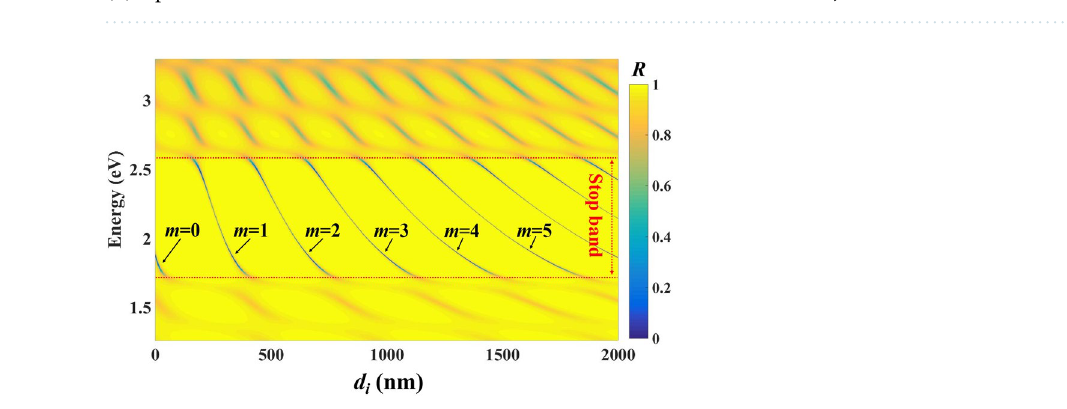
Figure 3. ( a ) Reflectance spectra of the extended Tamm structure at different thickness of interlayer (first-order TP mode). ( b ) Optical field distribution of the extended Tamm structure at 1.8204 eV when d i = 350.6 nm. ( c ) Reflectance spectra of the extended Tamm structure at different thickness of interlayer (second-order TP mode). ( d ) Optical field distribution of the extended Tamm structure at 1.8204 eV when d i = 691.2 nm.